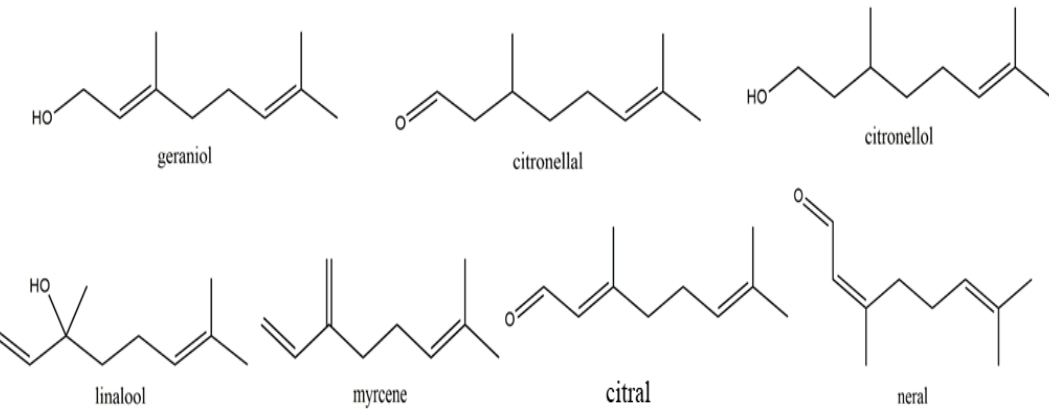
Figure 2. Structures of abundant volatile constituents of